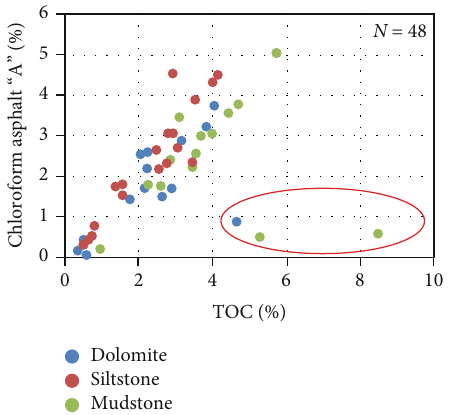
Figure 14: Relation diagram of chloroform asphalt “ A ” and TOC value of rock samples from Lucaogou formation.